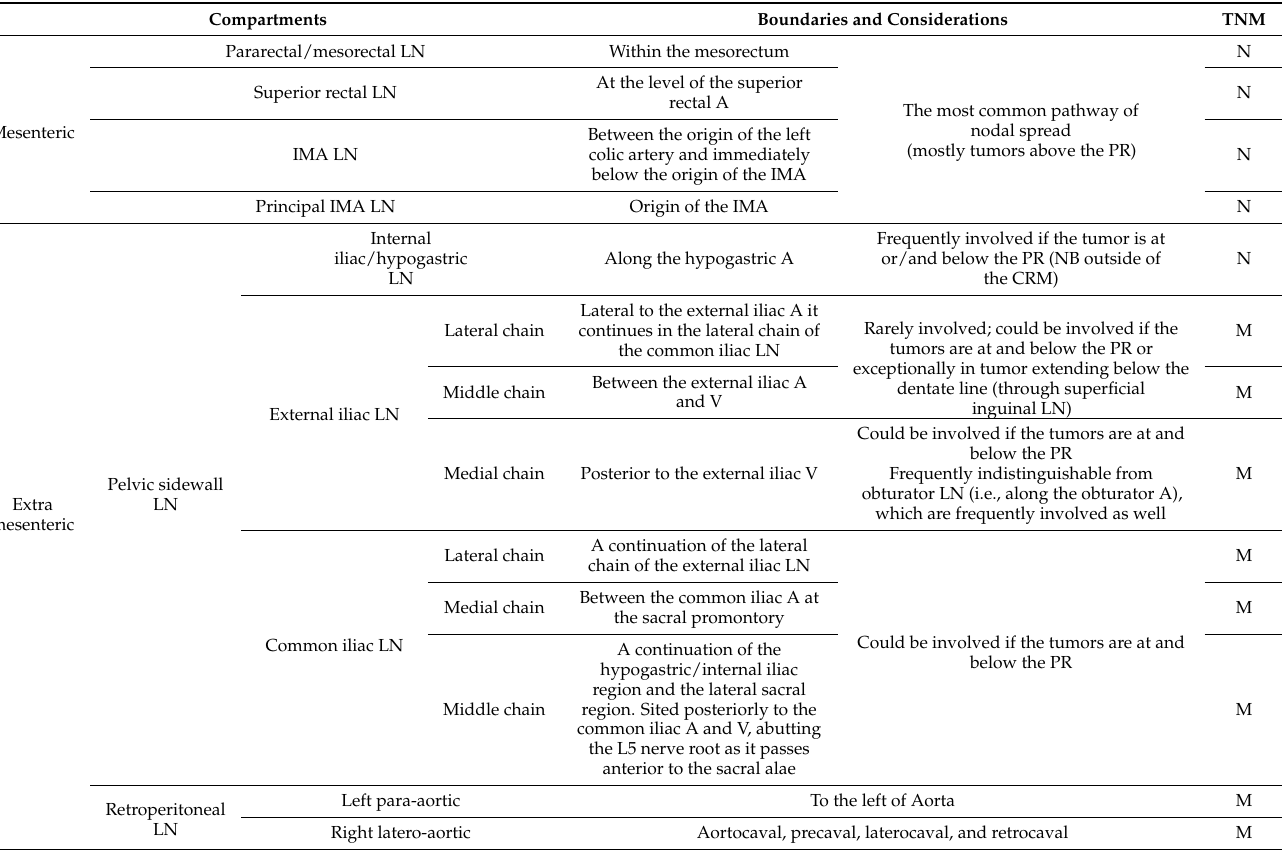
Table 1. Lymph nodes compartments and anatomical boundaries in N-stage assessment as for the AJCC-TNM 8th edition.